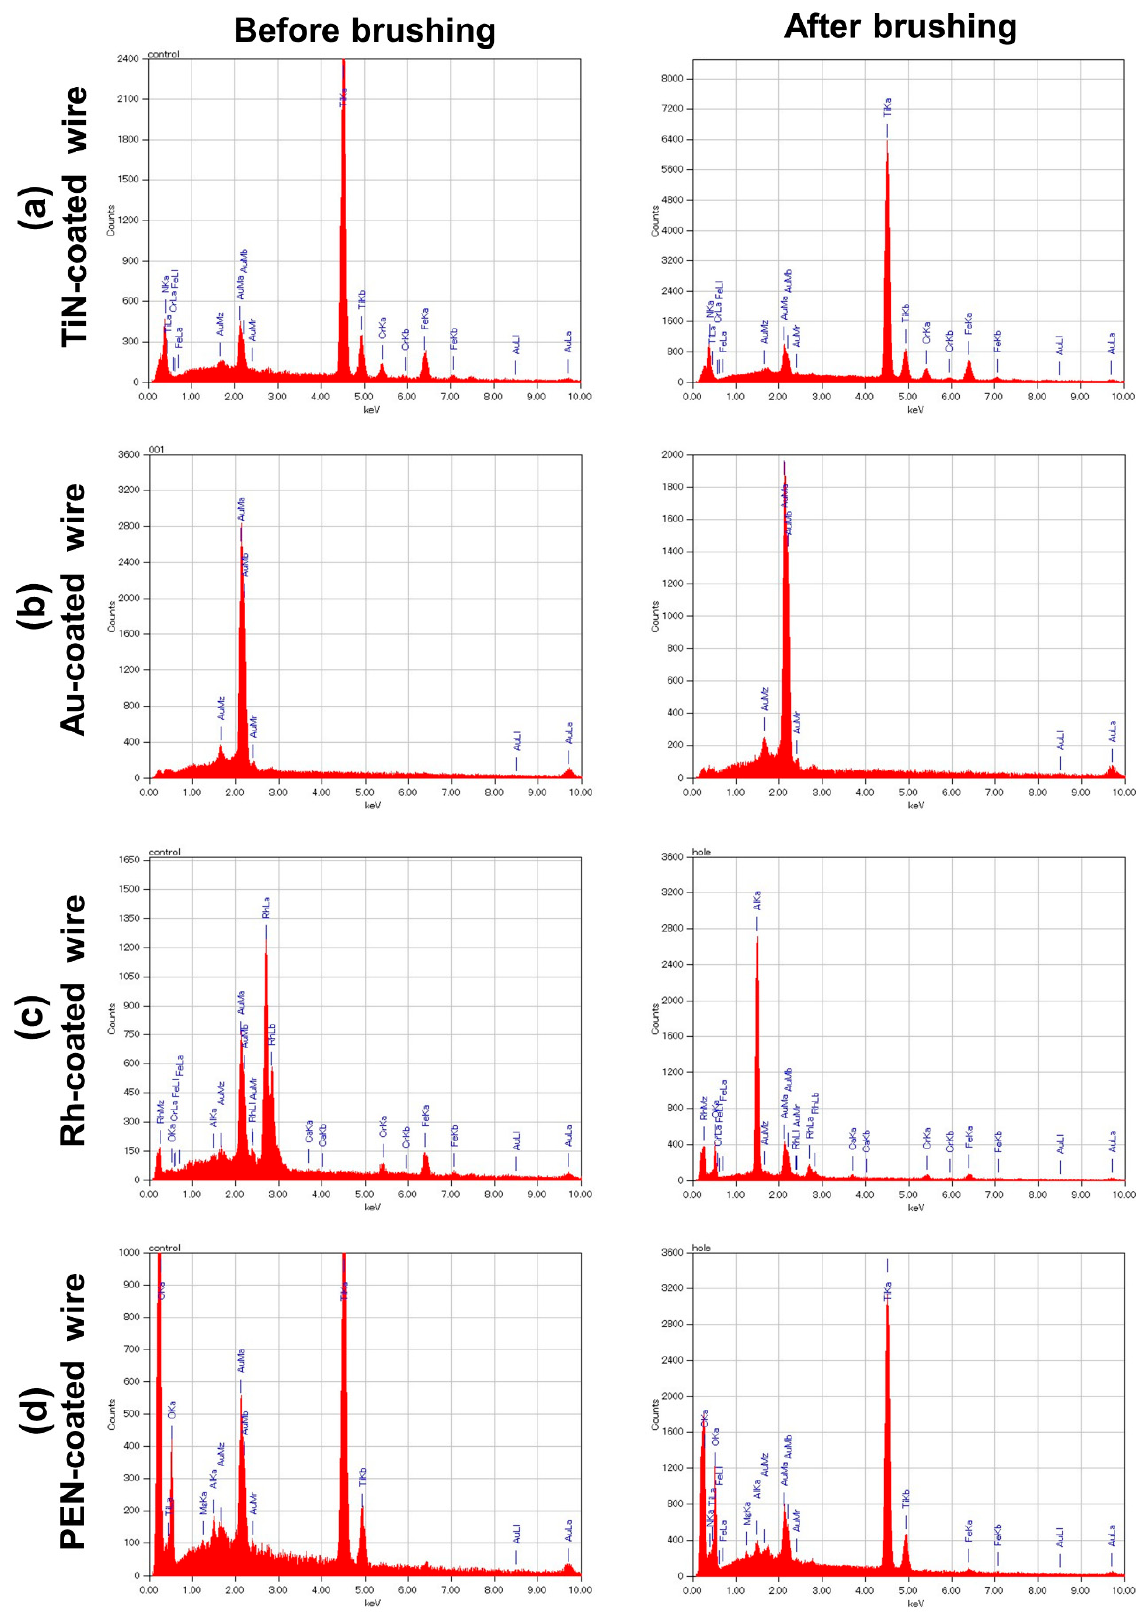
Figure 8. Energy dispersive spectrometry of four types of coated wire before and after brushing: ( a ) TiN-coated wire; ( b ) Au-coated wire; ( c ) Rh-coated wire; ( d ) PEN-coated wire.